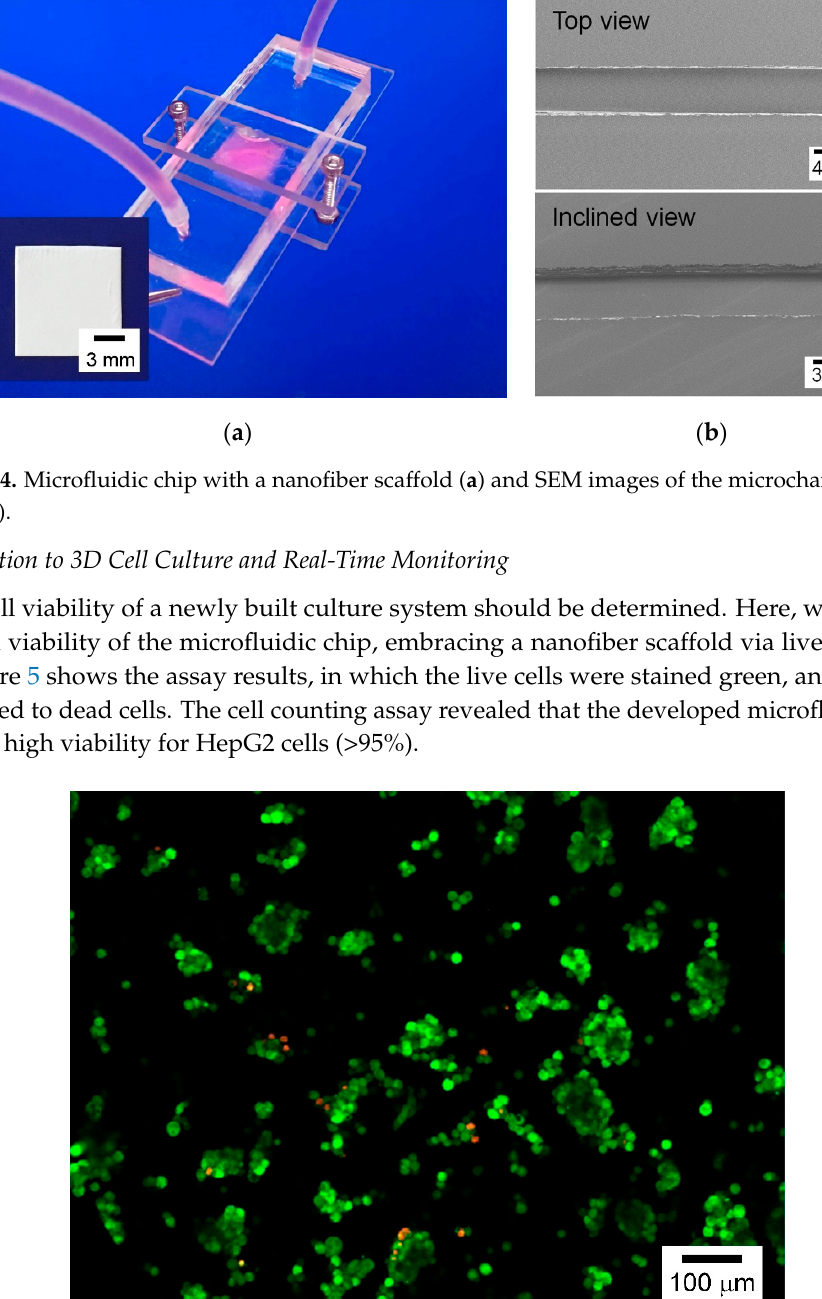
Figure 3. Electrospun nanofiber scaffold: ( a ) SEM images; ( b ) diameter distribution of the electrospun fibers; ( c ) porosity analysis result.